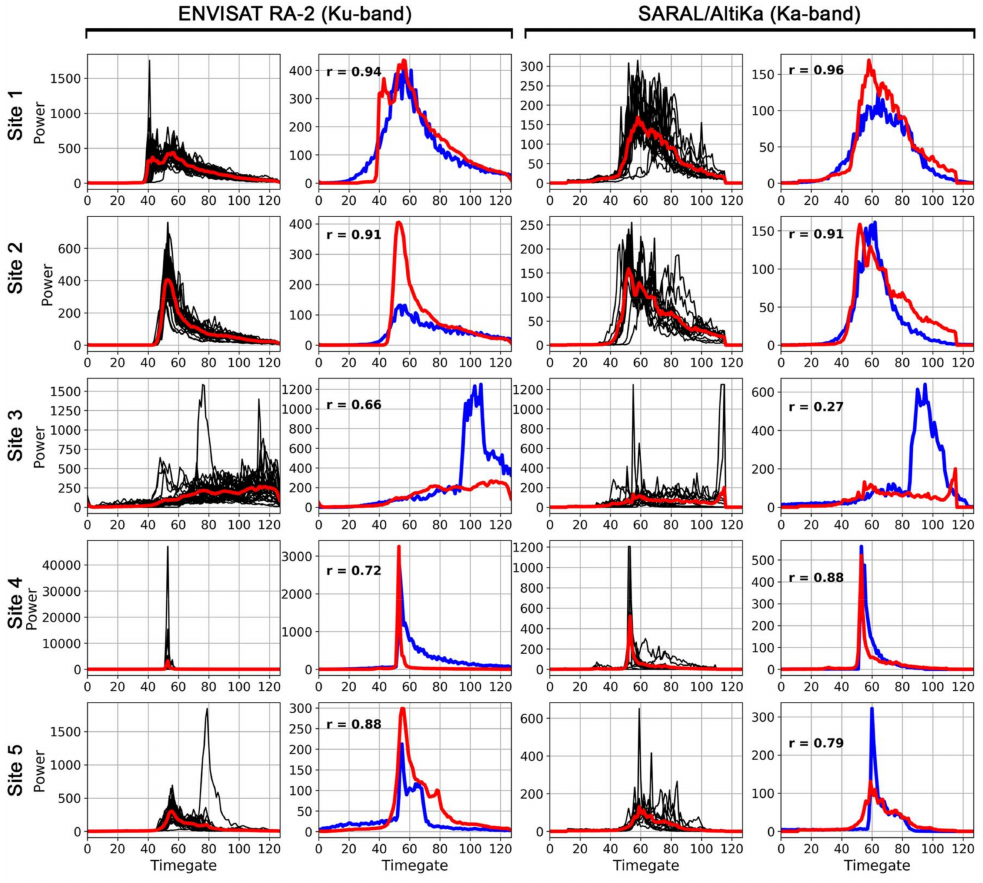
Figure 6. Individual (black) and mean (red) waveforms on the five study sites over the observation periods from ENVISAT RA-2 at Ku-band (left of the left panel) and from SARAL/AltiKa at Ka-band (left of the right panel). Comparison over the five study sites between the modeled waveform (in blue) and the mean observed waveform (in red), with the correlation coefficient r indicated from ENVISAT RA-2 at Ku-band (right of the left panel) and from at SARAL/AltiKa at Ka-band (right of the right